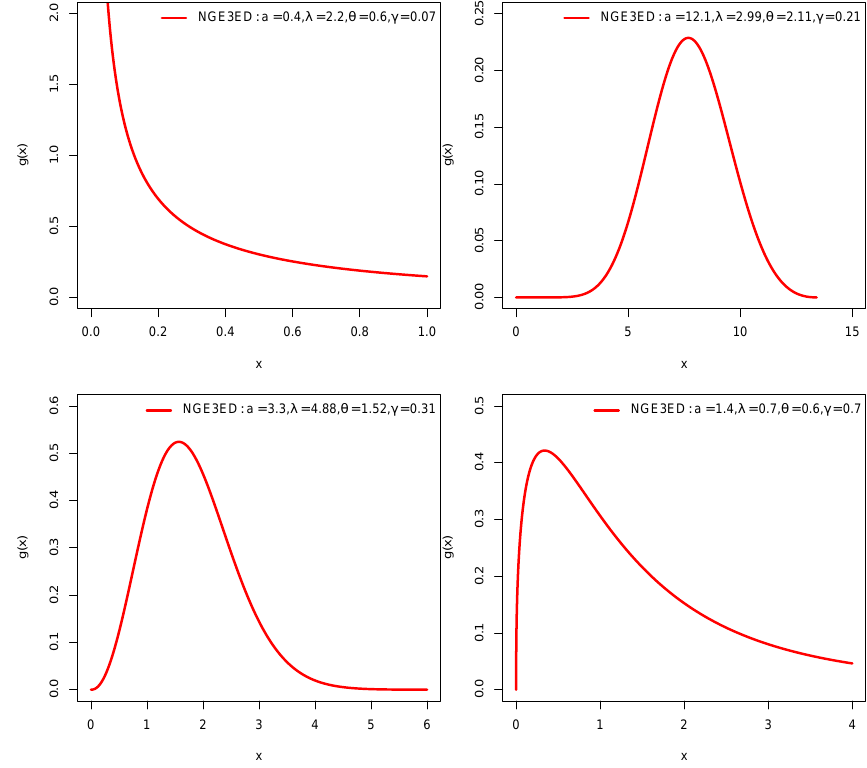
Figure 2. Pdf plots of